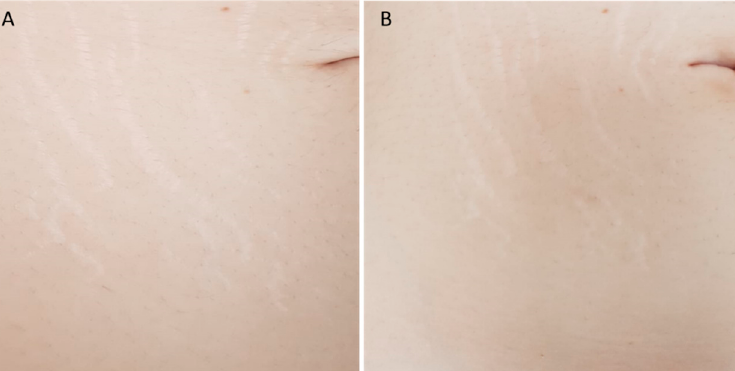
Figure 4. Photographic image of a patient’s umbilicus area with Striae distensae (SD) before treatment ( A ) and at 3M FU after the last treatment with Nd:YAP 1340 nm laser ( B ). A visible aesthetic improvement of SD is shown.